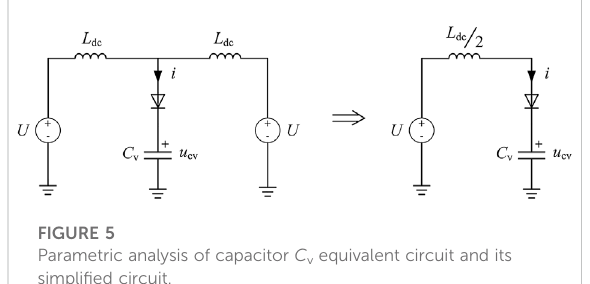
FIGURE 5 Parametric analysis of capacitor C v equivalent circuit and its simpli fi ed circuit.